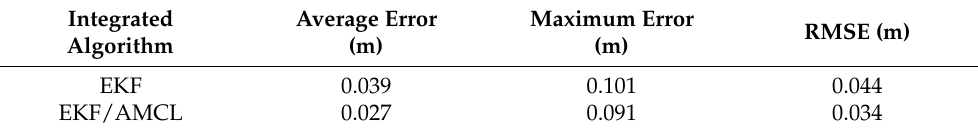
Figure 6. Comparison of lateral error between two integrated algorithms. Table 3. Analysis of lateral error of two integrated algorithms. Table 3. Analysis of lateral error of two integrated algorithms.